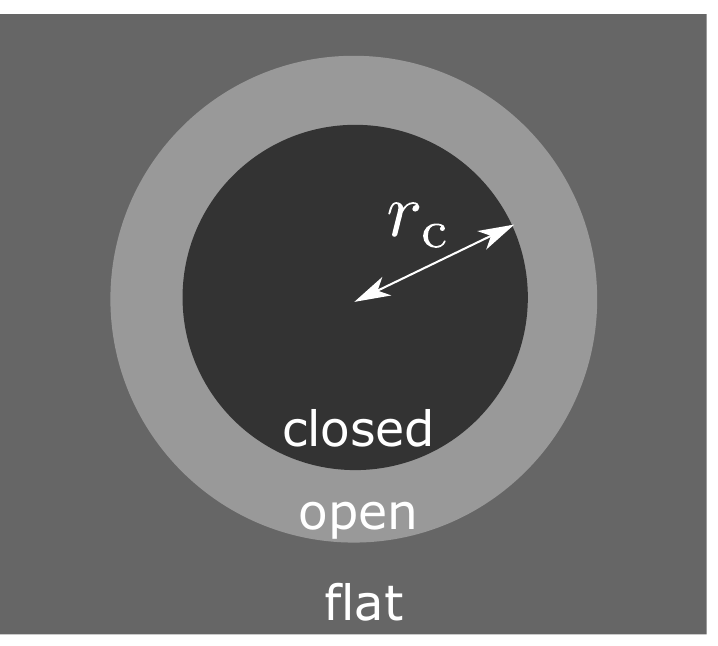
Figure 2. Schematic figure of the three-zone